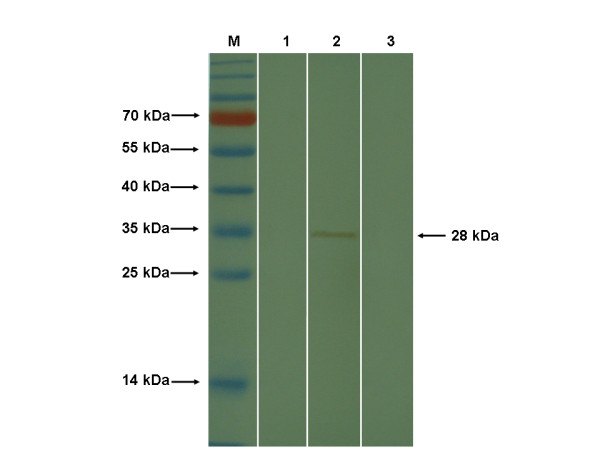
Analysis of immunoreactivity of mAb by western blot analysis. Purified virions of the PCV2a/LG strain were separated by SDS-PAGE, transferred to nitrocellulose membranes, and incubated with mAb. Lane M: protein molecular weight markers; lane 1: mAb 8E4; lane 2: mAb 6F10 as a positive control; lane 3: SP2/0 supernatant as a negative control.